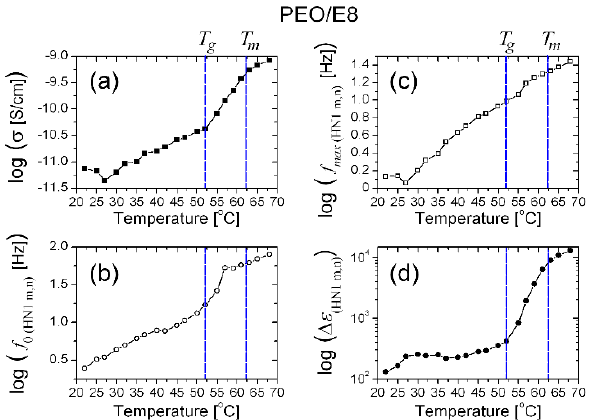
Figure 22. Temperature dependencies of the parameters σ ( a ), f 0 ( b ), f max ( c ) and Δε ( d ) obtained by fits on the ε ″ ( f ) spectra of the PEO/E8 composite ( ε ″ ( f ) spectra in Figure 20) using Equation (6).